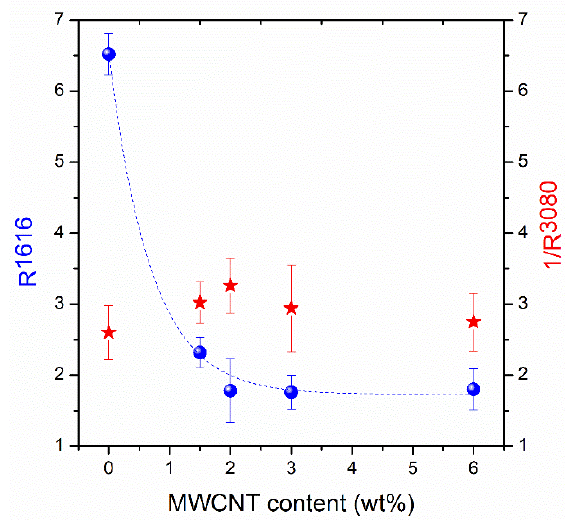
Figure 8. R values for the 1616 cm − 1 band and 1 / R values for the 3080 cm − 1 band as a function of MWCNTs content.